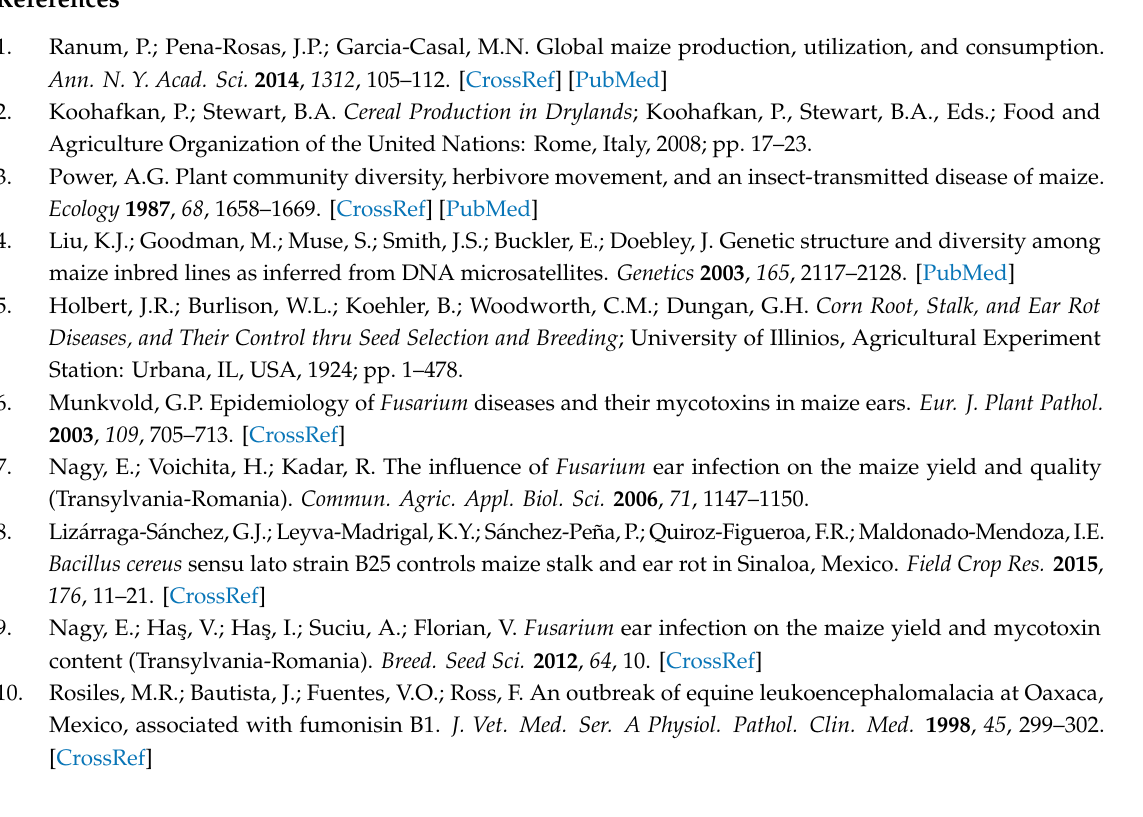
Table S1: Two-way analysis of variance (ANOVA) of post-germinative seedling rot dose-response assay at the VE stage, Table S2: Two-way analysis of variance (ANOVA) of seedling rot dose-response assay at the V2 stage, Table S3: Two-way analysis of variance (ANOVA) of plantlet rot assay at the V4 stage, Table S4: Two-way analysis of variance (ANOVA) of stalk rot resistance assay, Table S5: Two-way analysis of variance (ANOVA) of maize ear rot resistance